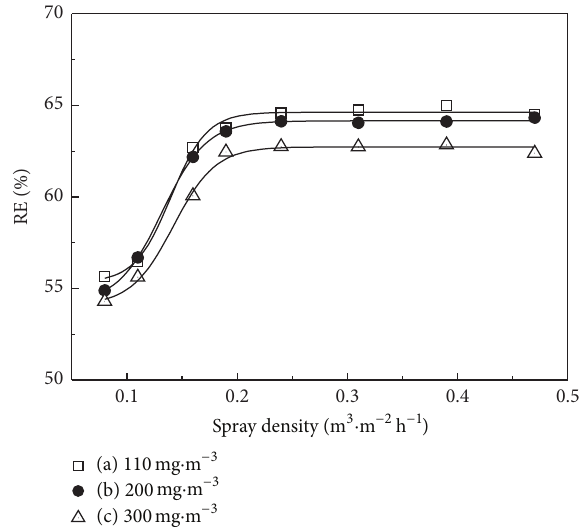
Figure 6: The effects of spray density on ethanethiol removal